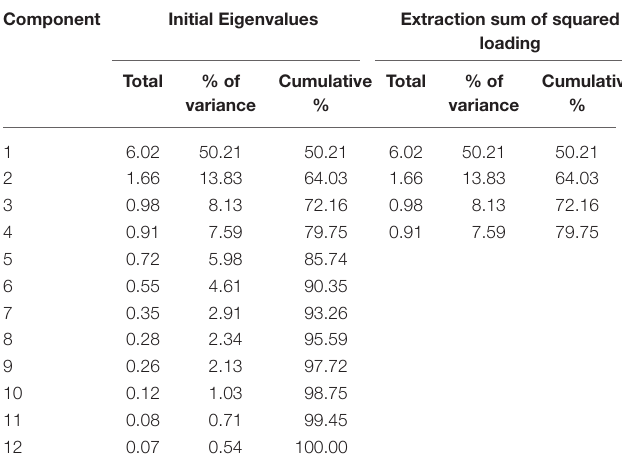
TABLE 2 | Total variance explained by different